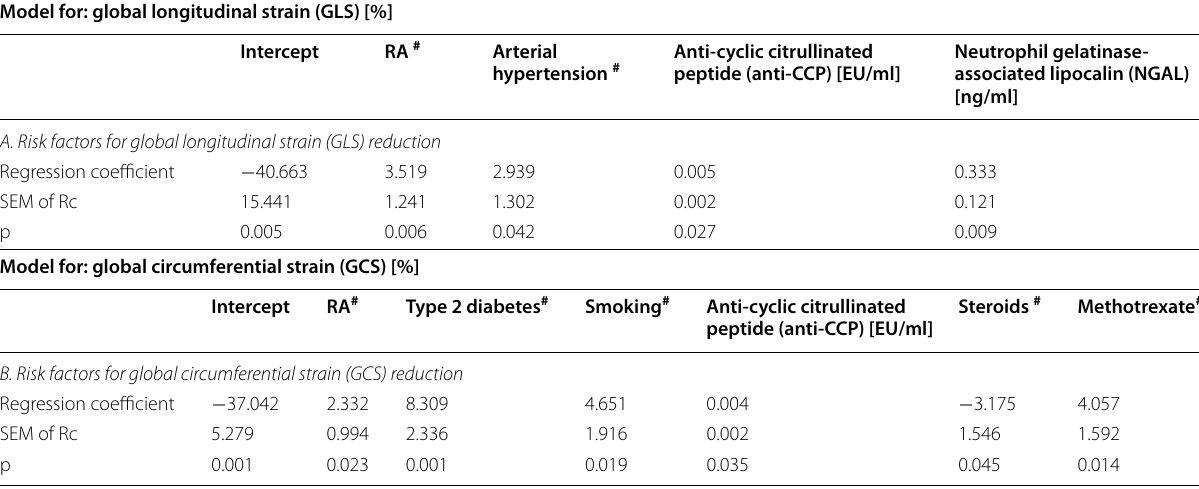
Table 5 Results of regression analysis in the study group of patients Model for: global longitudinal strain (GLS)